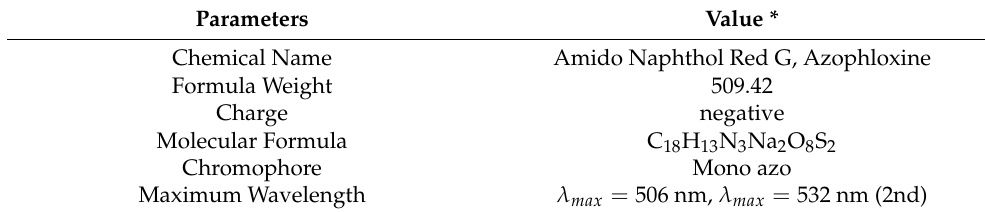
Figure 1. Chemical structure of CI Acid Red 1 dye (https://www.sigmaaldrich.com, Accessed Date: 21 February 2019). Table 1. Properties of Acid Red 1 dye.